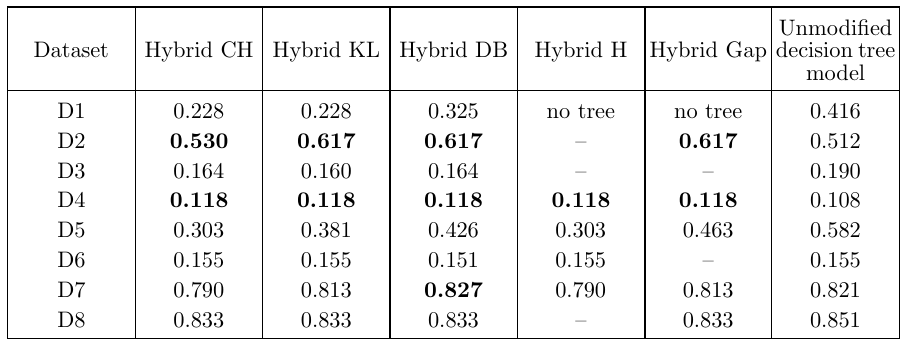
Values of F-measure